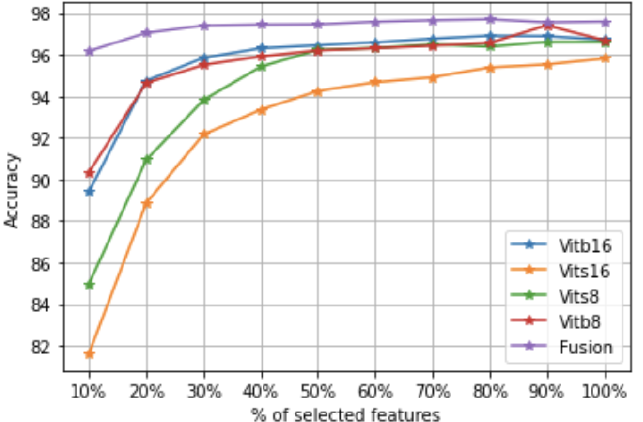
Figure 5. Rate of important feature effects on the classification accuracy of the UC Merced data set with 50% of randomly selected images per